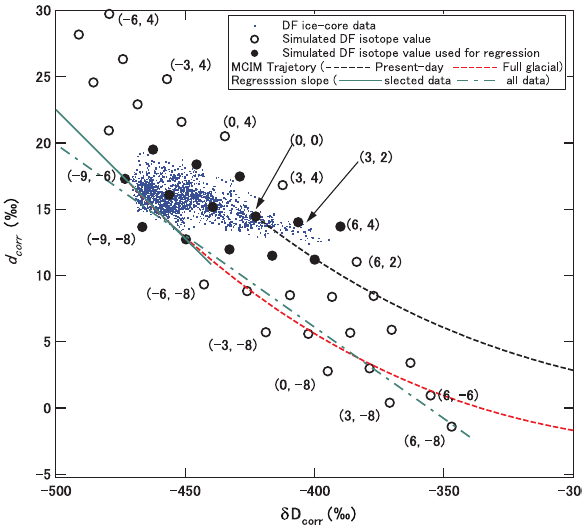
Fig. 5. Simulated δ D and d values in Antarctica. Trajectories of present-day (black dotted line) and glacial conditions (red dotted line) are shown. Each point (solid or open circles) represents the simulated snow isotope values at DF site under a specific site and source temperature setting, shown as ( 1T site , 1T source ) in ◦ C . The DF ice core data (blue dot), and data used for regression analysis were shown as black solid circle. Linear regression d / δ D slopes of a constant 1T source ( = − 6.0 ◦ C ) obtained for the filled circles and all circles are shown as green solid and chain lines, respectively. Here, δ D and d are corrected for δ 18 O sw , see text for